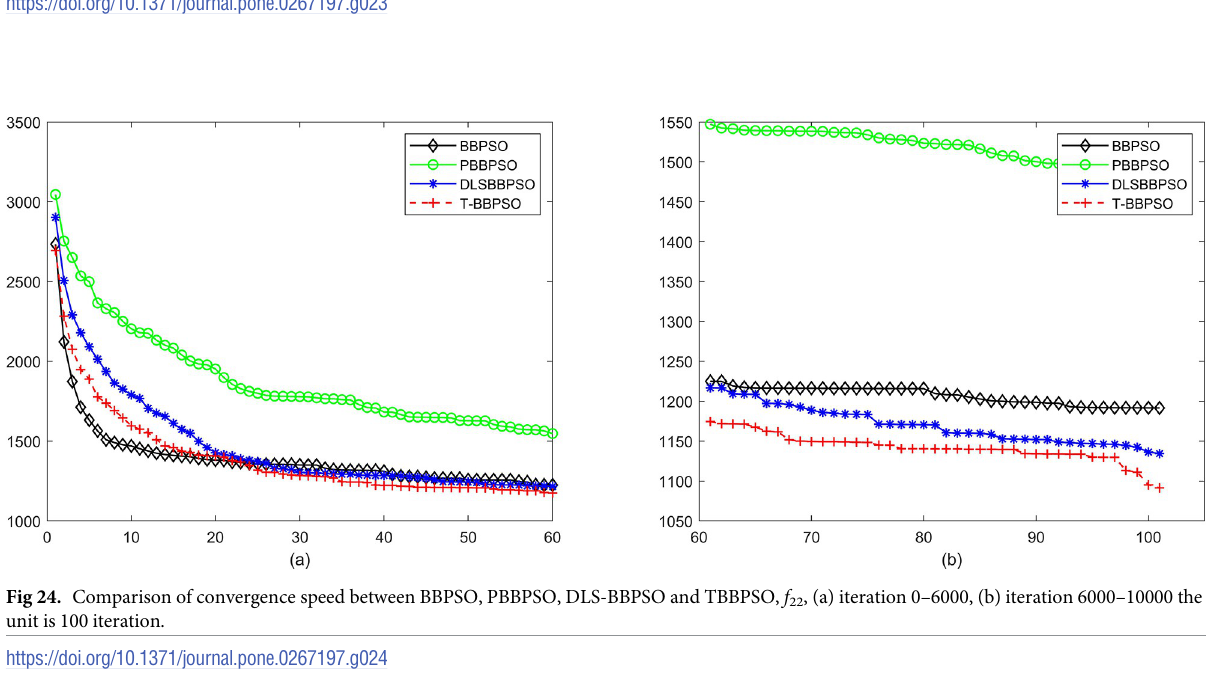
Fig 23. Comparison of convergence speed between BBPSO, PBBPSO, DLS-BBPSO and TBBPSO, f 21 , (a) iteration 0–6000, (b) iteration 6000–10000 the unit is 100 iteration.